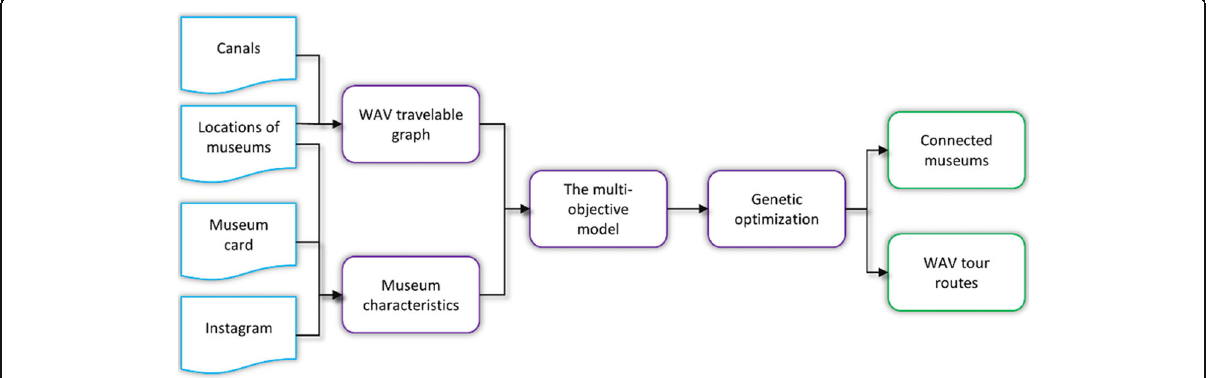
Fig. 3 Workflow to design WAV routes for museums